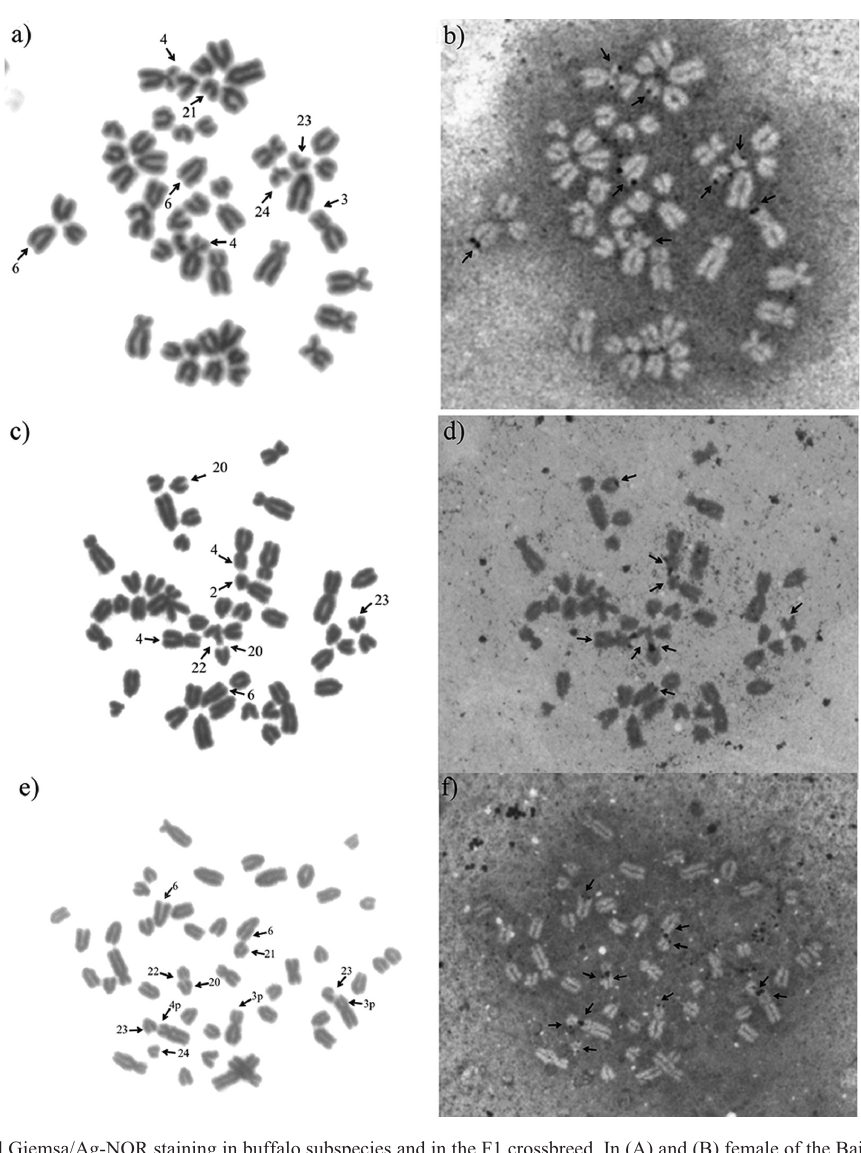
Figure 1 - Sequential Giemsa/Ag-NOR staining in buffalo subspecies and in the F1 crossbreed. In (A) and (B) female of the Baio type (2n = 50) with Ag-NORs in chromosomes 3p, 4p, 6, 21, 23 and 24. In (C) and (D) male Carabao breed (2n = 48) with Ag-NORs in 4p, 6, 20, 22 and 23. In (E) and (F) F1 female crossbreed (2n = 49) with 11 Ag-NOR-bearing chromosomes, eight of which show associations. The arrows point the Ag-NORs.